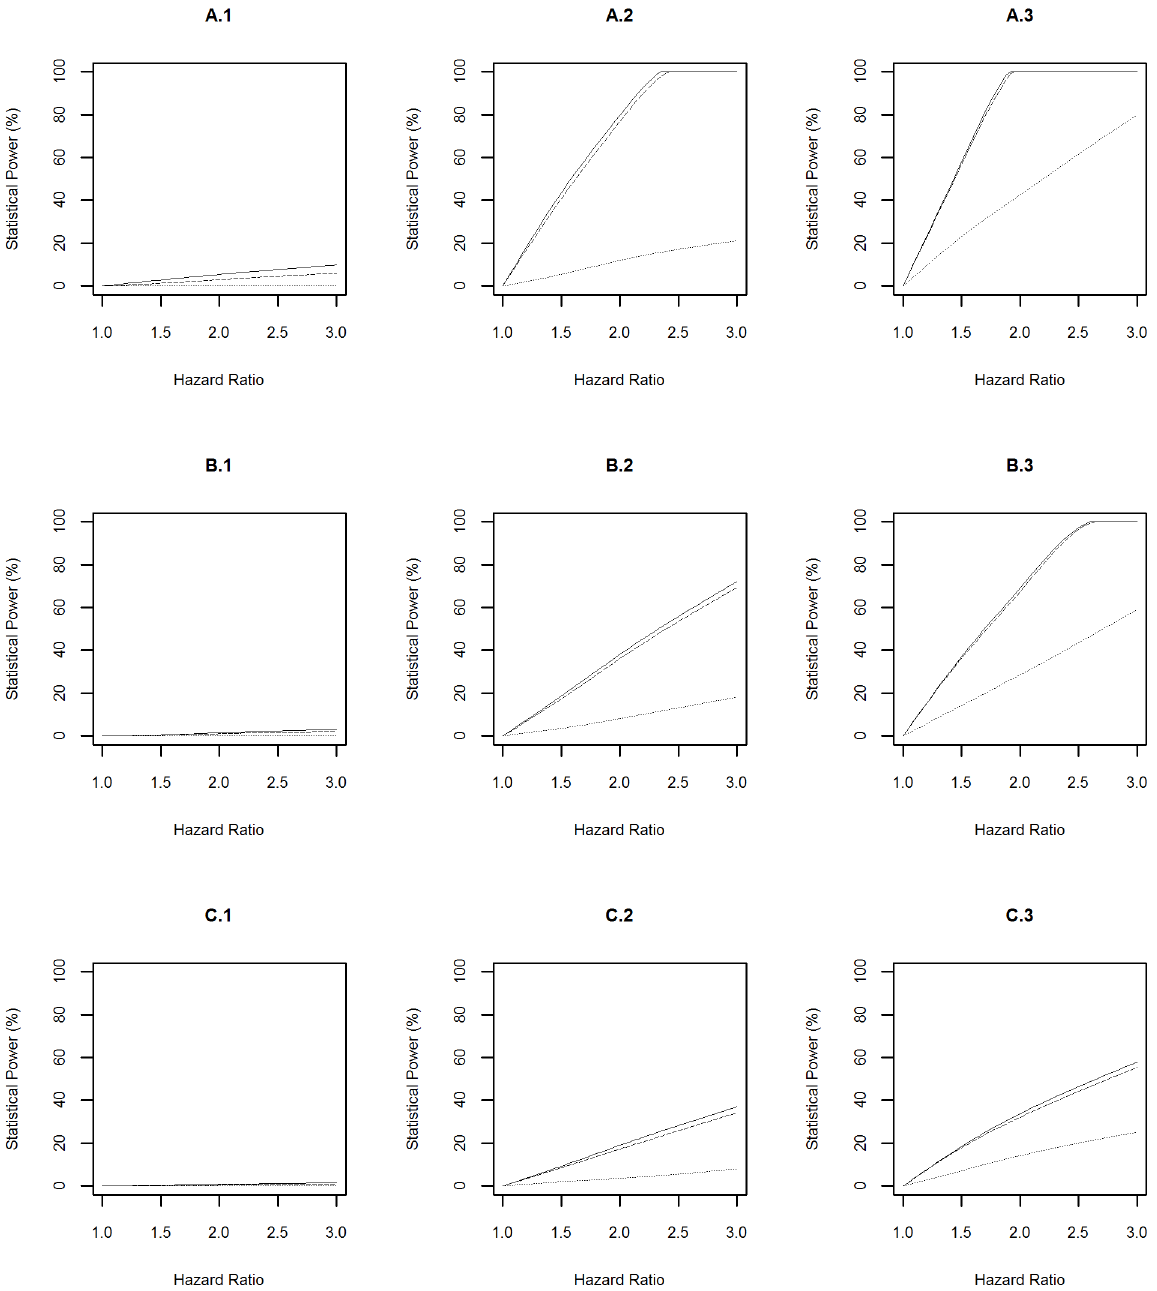
Fig 5. Power Profile at Significance Level of 0.0001 for Gene-Environment Interaction. “ A ” , “ B ” and “ C ” represent diabetes, dementia and Parkinson ’ s disease respectively. “ 1 ” , “ 2 ” and “ 3 ” represent that both environmental and genetic risk factors are rare (prevalence = 0.01), common (prevalence = 0.1), and very common (prevalence = 0.2) respectively. The solid, dashed and dotted lines represent the statistical power profile of the study assuming subjects undergo health monitoring continuously, subjects undergo repeated measures every three years, and subjects undergo repeated measures every three years and the both environmental and genetic risk exposures are subject to measurement error (0.1 for environmental risk exposure and 0.01 for genetic risk exposure) respectively.